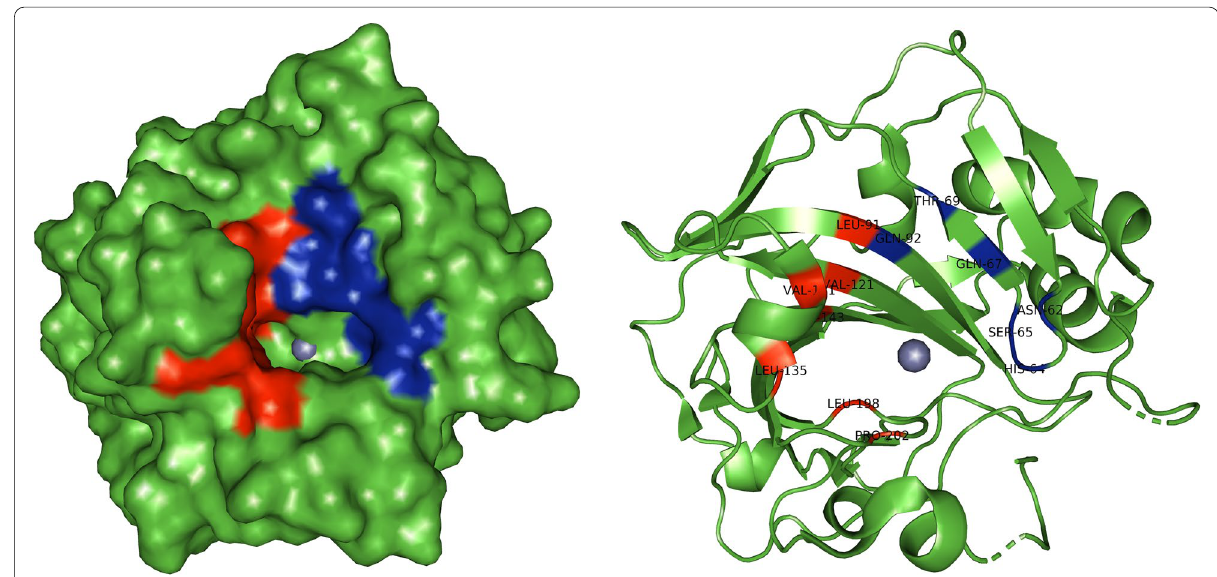
Fig. 8 Visualization of the active site location